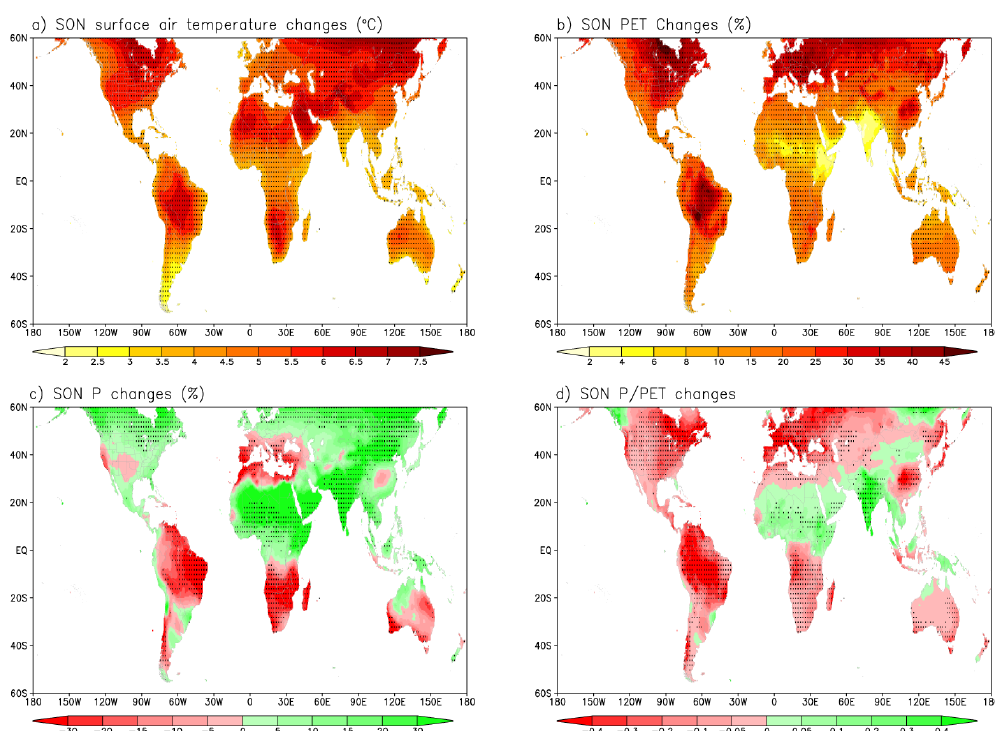
Fig. 14. Same as Fig. 7 but for the season of